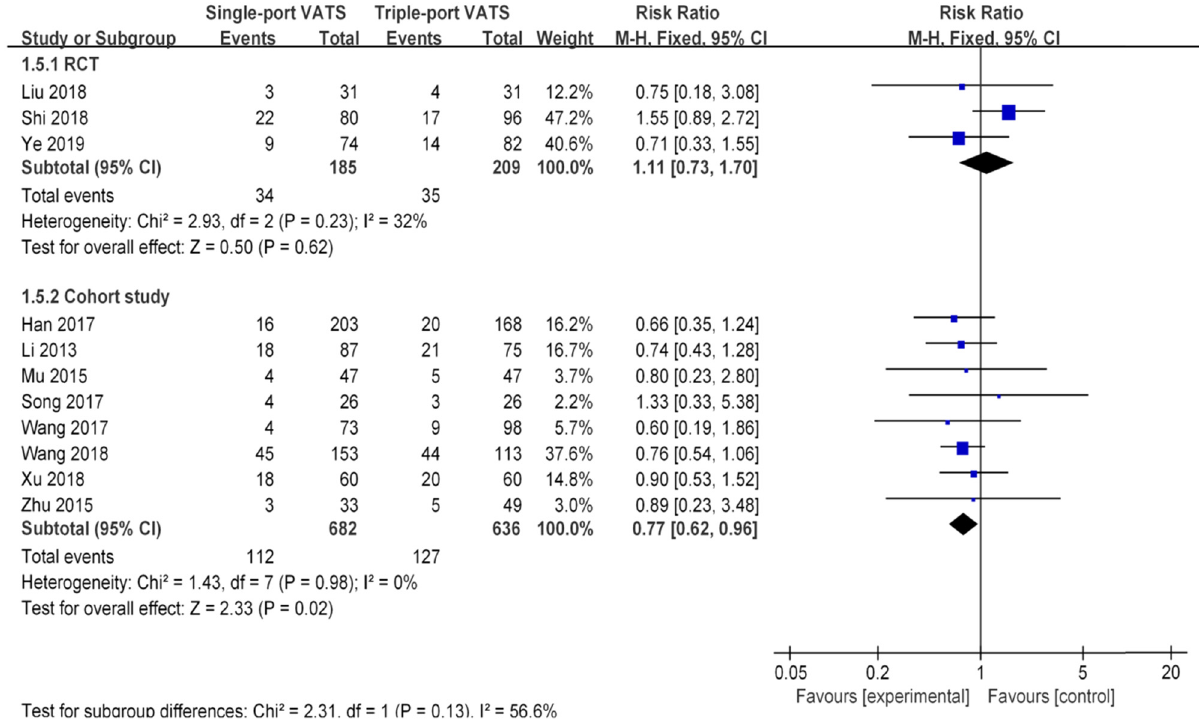
Figure 6: Forest plots of postoperative complications for single - and triple - VATS. For each study, the estimated OR ( shown as square ) and its 95% CI ( shown as horizontal line ) were plotted. The pooled OR and 95% CI were plotted as black